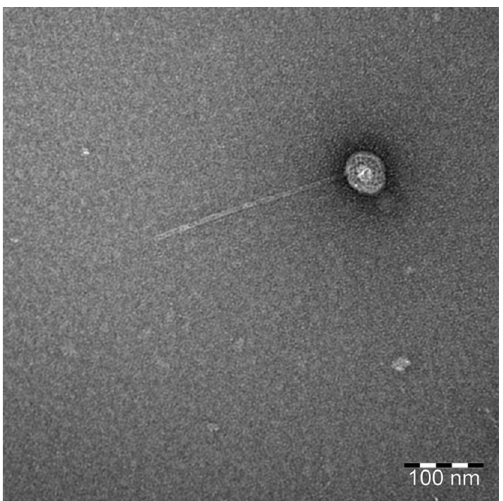
Figure 3. Negative staining transmission electron microscopic image of the phage vB_EcoS_ULI-O80_Stx2d.